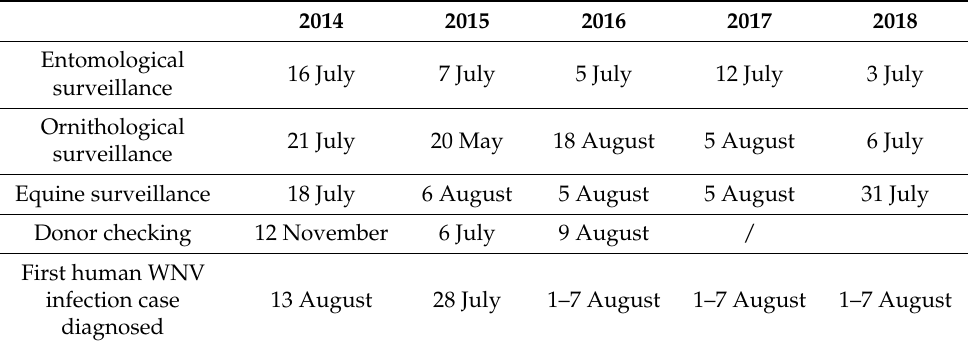
Table 5. First positive cases of West Nile Virus detected by veterinary and human surveillance between 2014 and 2018.